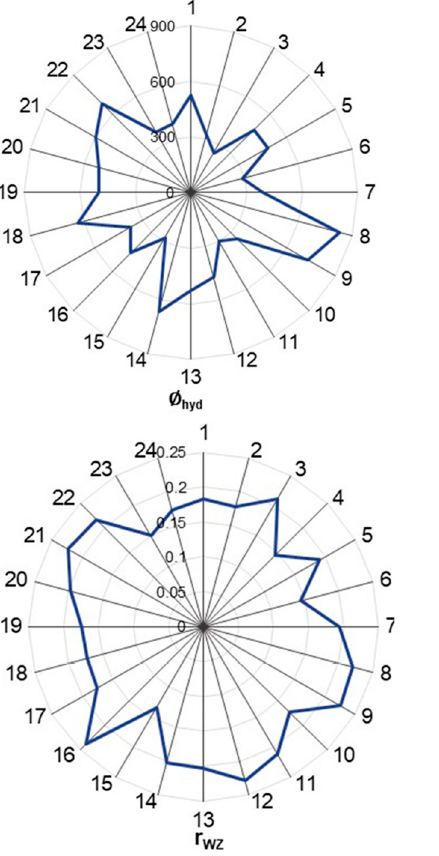
Figure 2. Radar plot of the distribution of used descriptors.